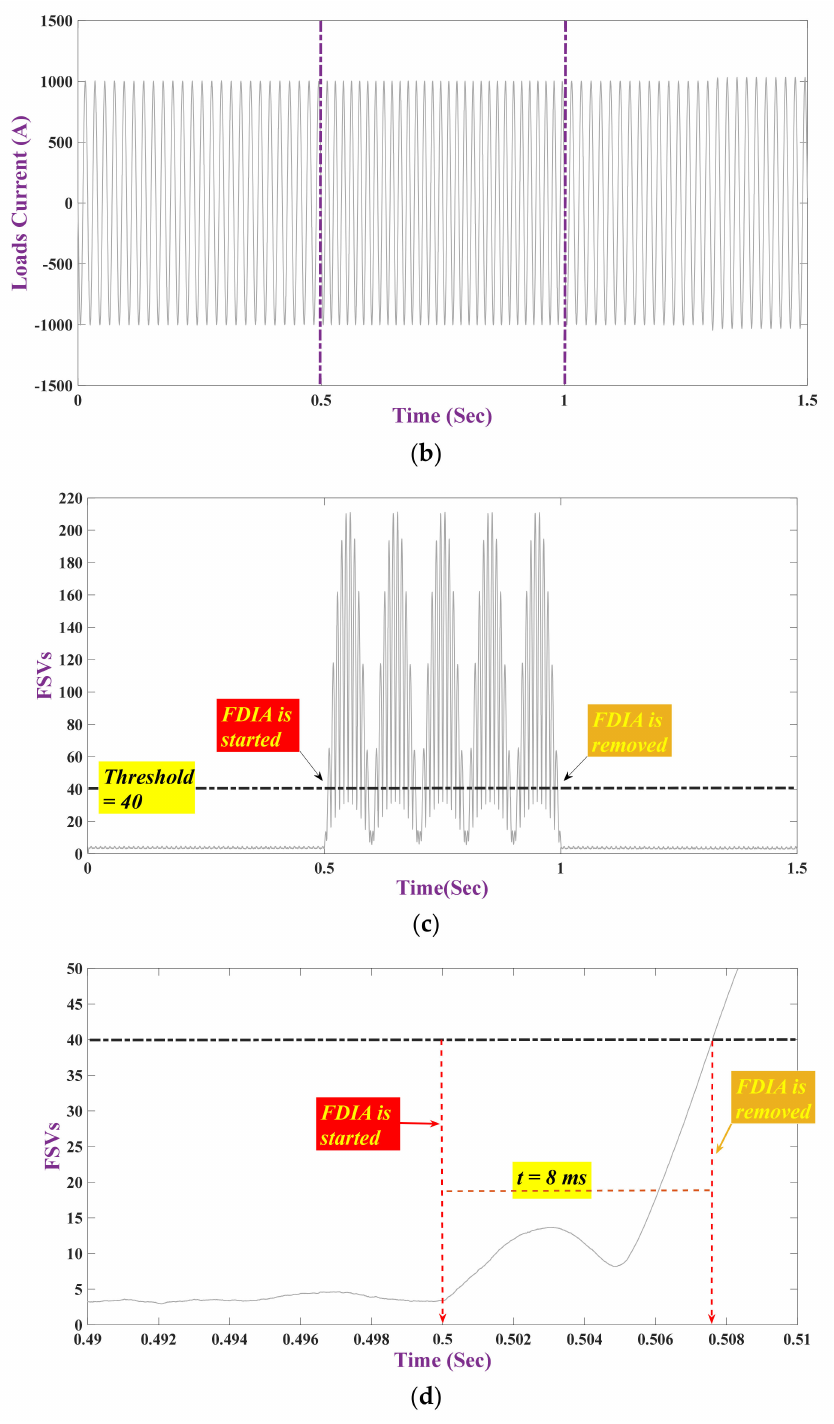
Figure 6. Instability stems from getting started on the attack via manipulating the voltage reference waveform’s frequency: ( a ) ISMG’s voltage; ( b ) Loads current; ( c ) FSVs of signals; ( d ) Time response of FSV’s scheme (FDIA is initiated at t = 0.5 s and is omitted at t = 1 s). Case study III: Instability stems from manipulating the voltage reference signal according to shift in the signal In this case, the efficiency of the FSVs in FDIA detection is considered by manipulating the voltage reference signal according to shift the signal to simulate the